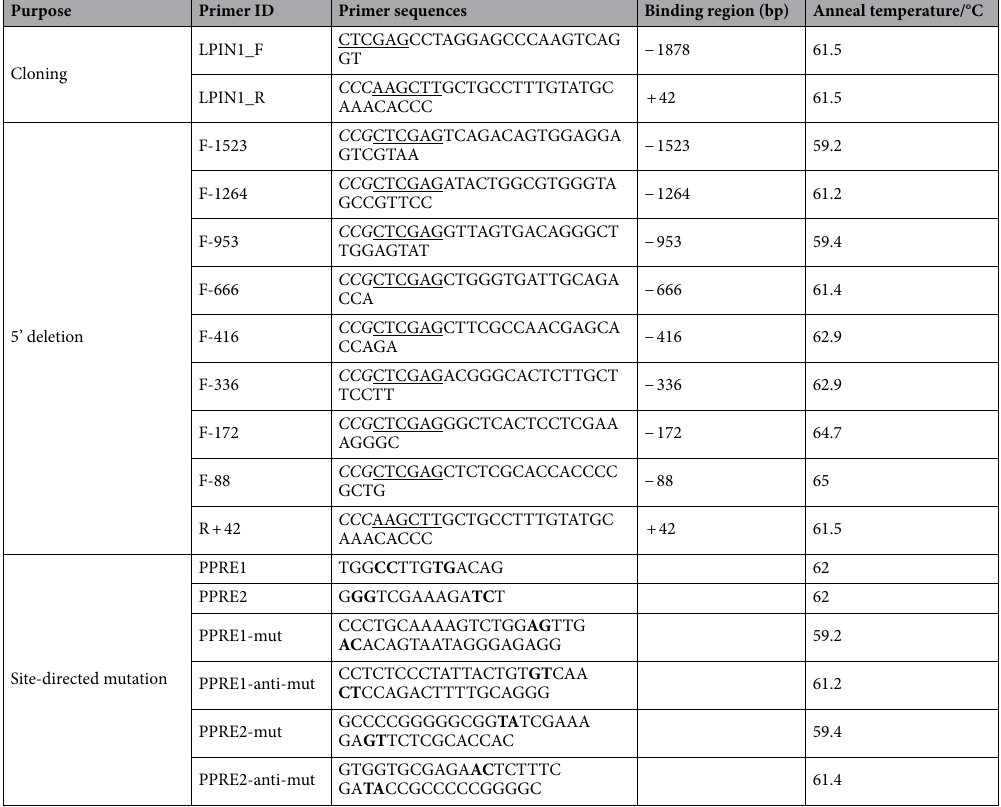
Table 3. Primers used in the construction of luciferase reporter vector. Plus ( +) and minus (-) indicate the number of nucleotides upstream (−) and downstream ( +) from the transcriptional start site. The underlined bases are the restriction site. The bases of italic are the protective bases. Mutation bases are shown in bold